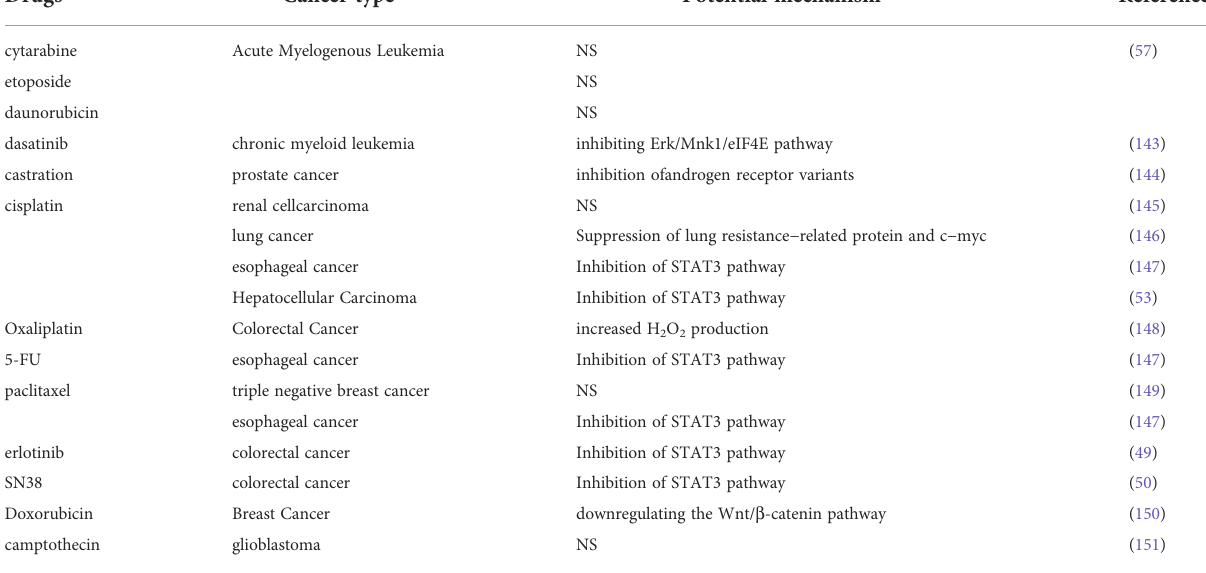
TABLE 2 Niclosamide has synergetic effect with